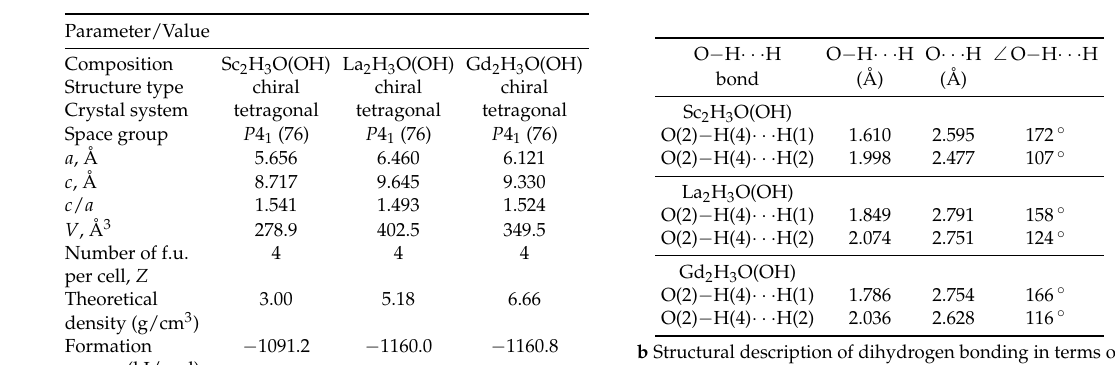
Table 6. Crystal chemistry of substituted hydroxyhydrides M 2 H 3